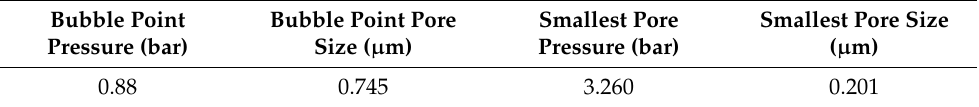
Figure 3. Pore size distribution of the capillary PTFE membrane used in the present study. Table 2. Dimensions of capillary PTFE membranes used in the present